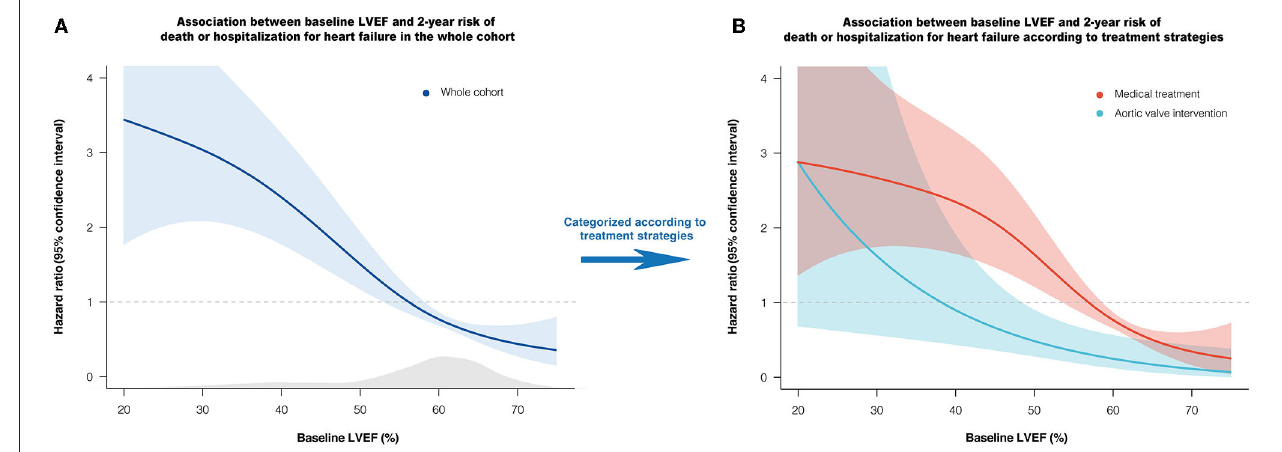
FIGURE 1 | Association between baseline LVEF and relative hazard of 2-year death or HHF. Penalized spline curves demonstrate the shape of the association in overall (A) , medically and AVI managed patients (B) , with 95% confidence interval. The gray area underneath the curve indicates the density of the population. The horizontal line at HR = 1 represents the mean risk of the cohort. AVI, aortic valve intervention; HHF, hospitalization for heart failure; LVEF, left ventricular ejection fraction.